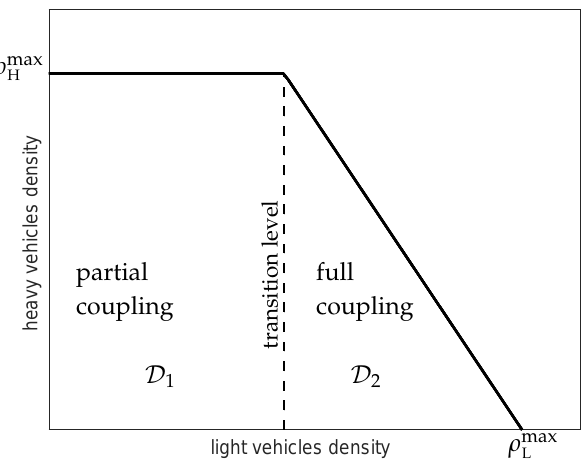
Figure 5. Domains